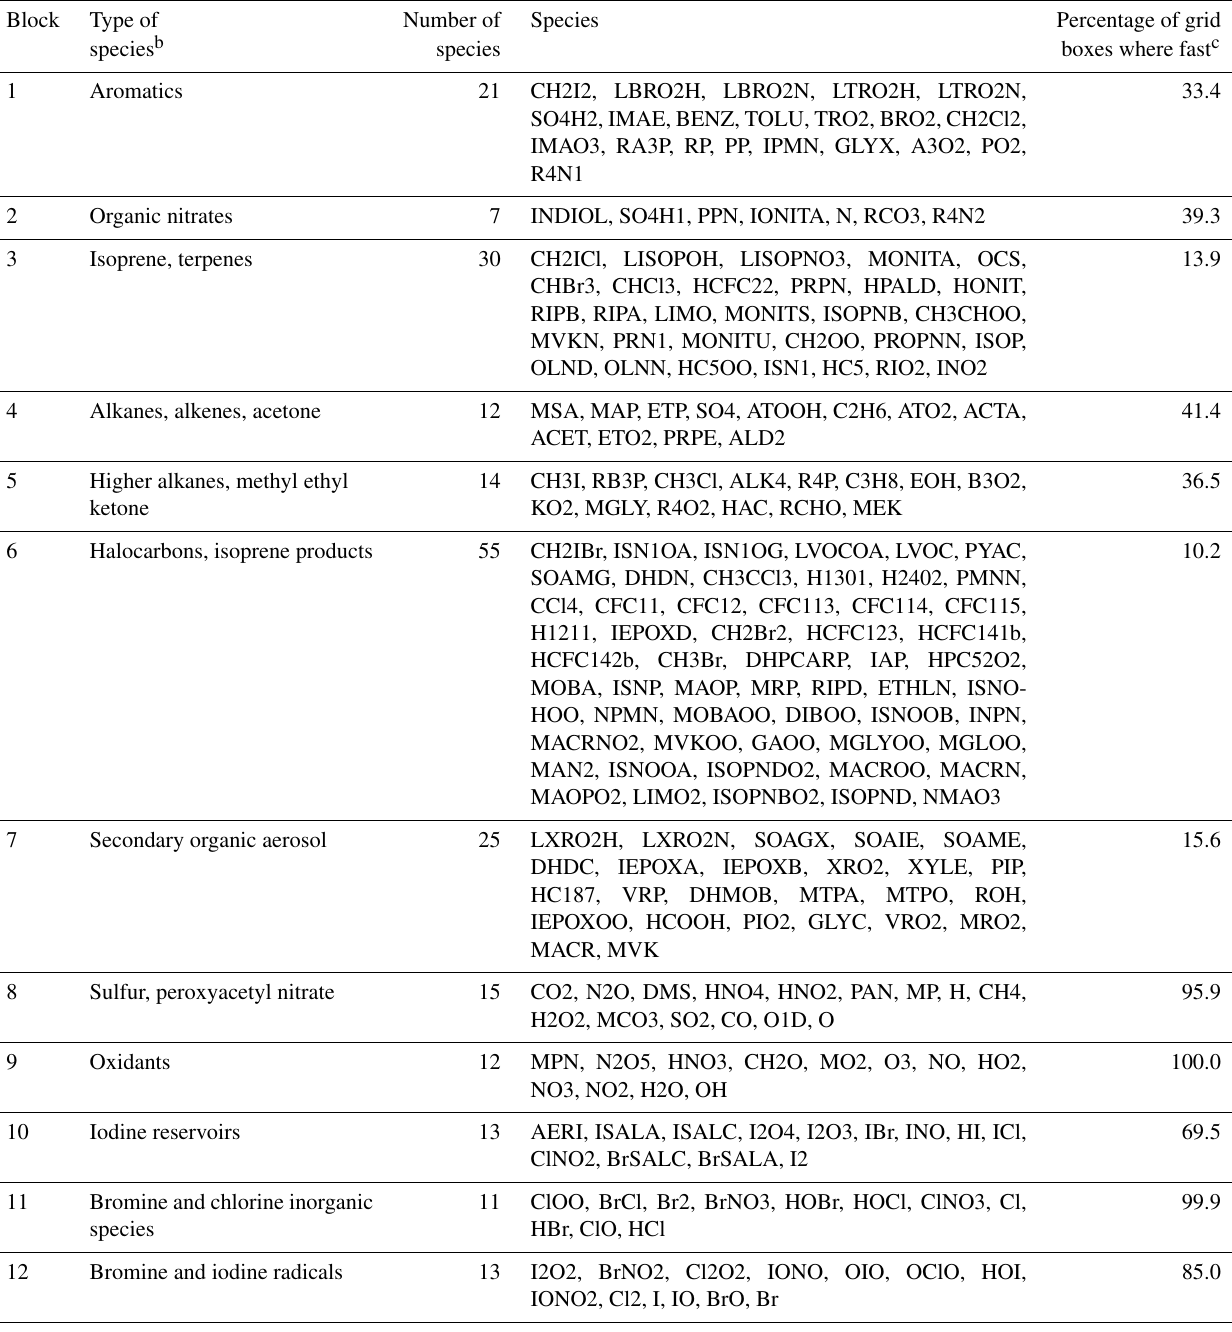
Table 1. Partitioning of GEOS-Chem chemical species into N = 12 blocks. a